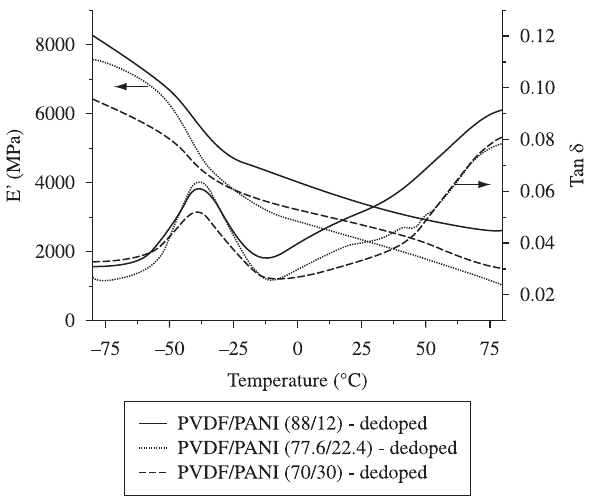
Figure 11. Stress-strain curves of: a) PVDF; b) PVDF/PANI (12 wt. (%) PANI); and c) PVDF/PANI (22,4 wt. (%) PANI). The blends were redoped with HC 0,05 M.